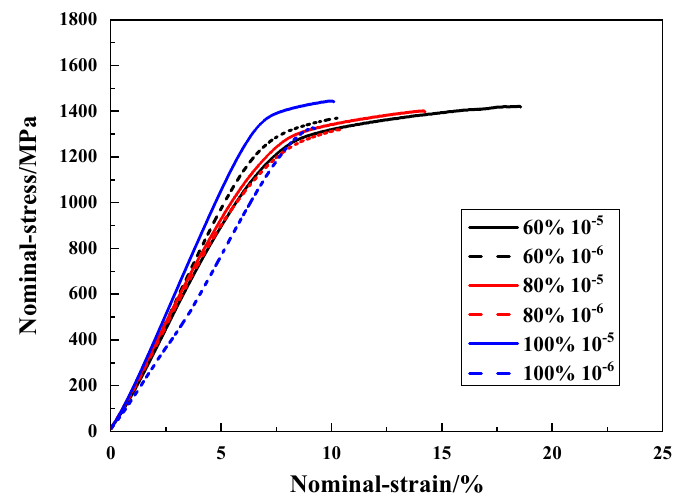
Figure 5. Nominal stress–strain curves under humidity for M7B. Table 2. Mechanical properties and sensitivity of hydrogen embrittlement after slow strain rate tensile test (SSRTT) for M7B.